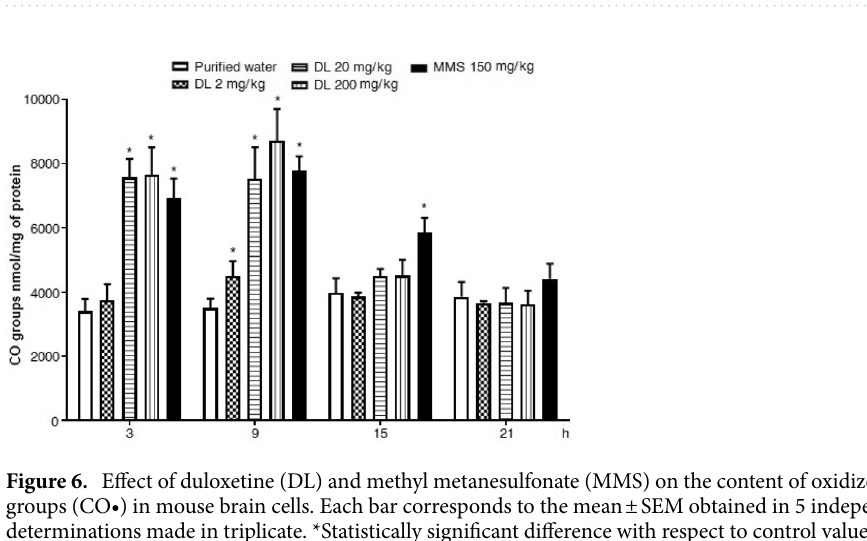
Figure 5. Effect of duloxetine (DL) and methyl metanesulfonate (MMS) on the content of malondialdehyde (MDA) in mouse hepatic cells. Each bar corresponds to the mean ± SEM obtained in 5 independent determinations made in triplicate. *Statistically significant difference with respect to control value. ANOVA and post hoc Student–Newman–Keuls tests ( p ≤ 0.05).